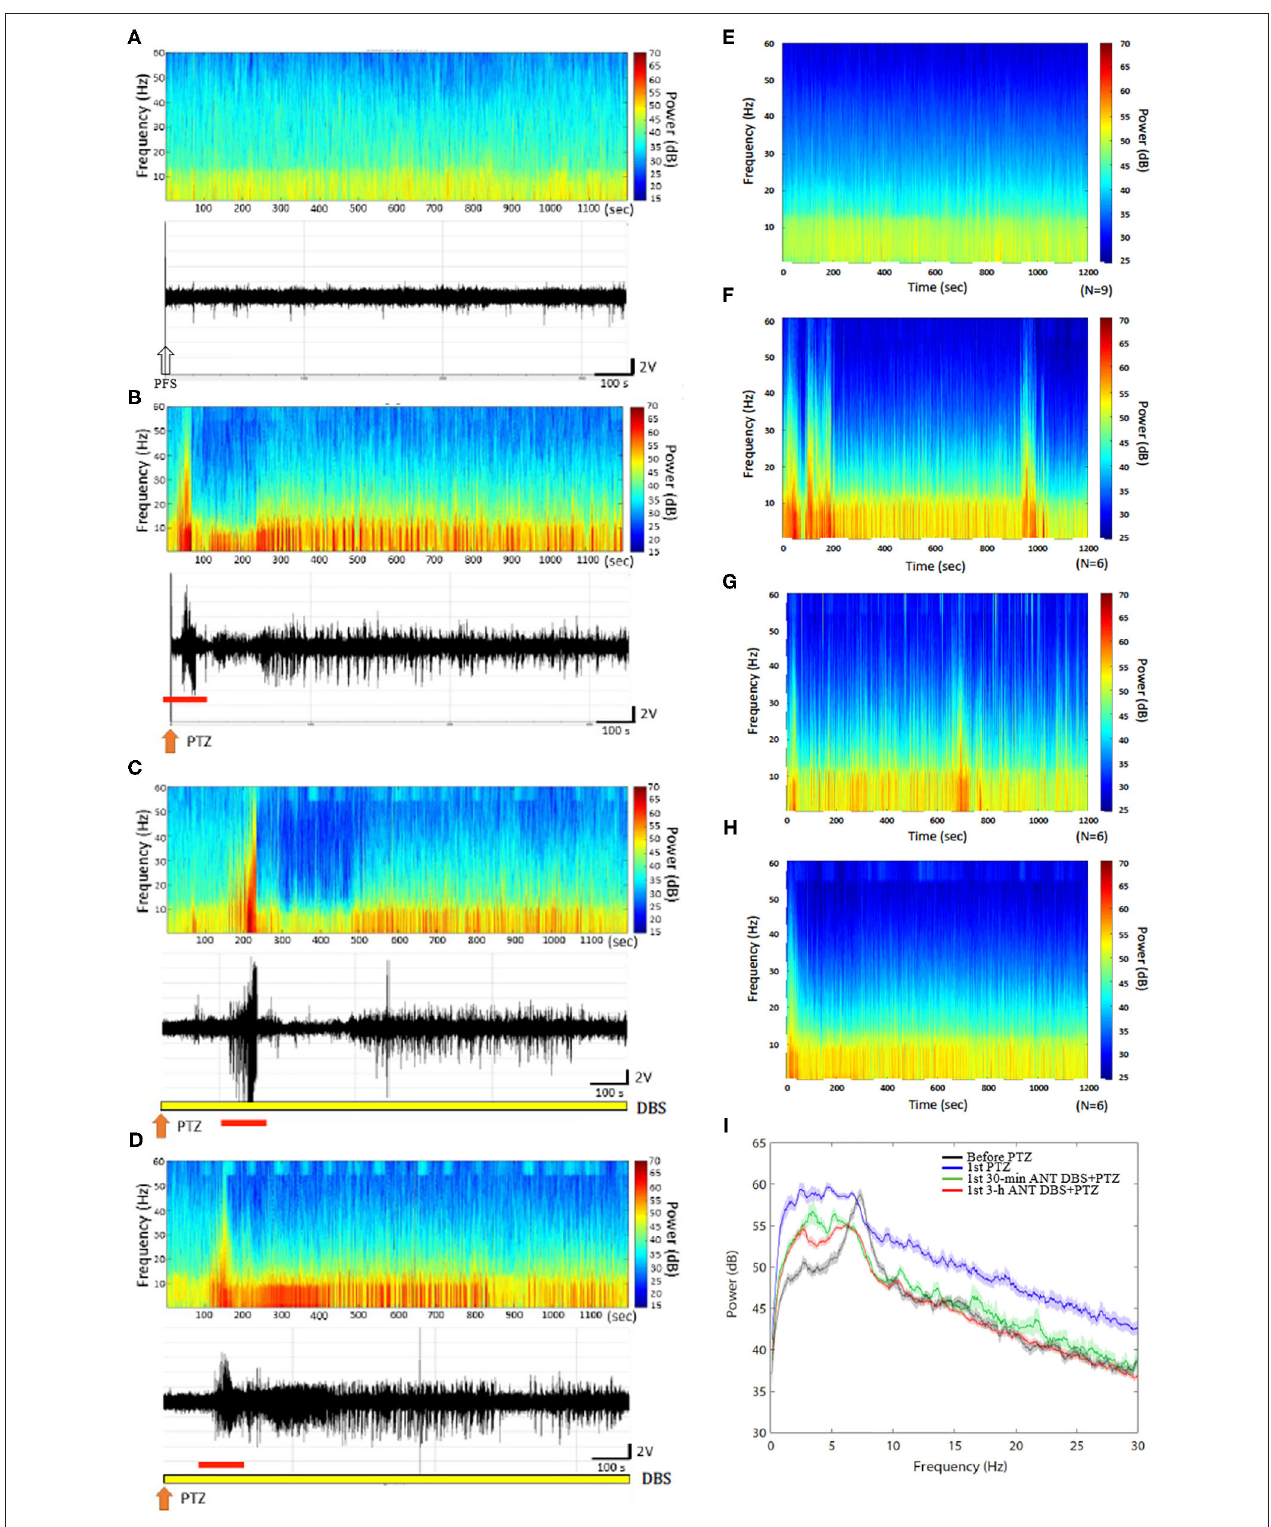
FIGURE 3 | Anterior nucleus of thalamus (ANT) deep brain stimulation (DBS) suppressed the 1st pentylenetetrazol (PTZ) injection-induced enhancement of power spectrum. (A) The power spectrum and the raw electroencephalogram (EEG) obtained after the vehicle (pyrogen-free solution) injection in one rat. (B) The